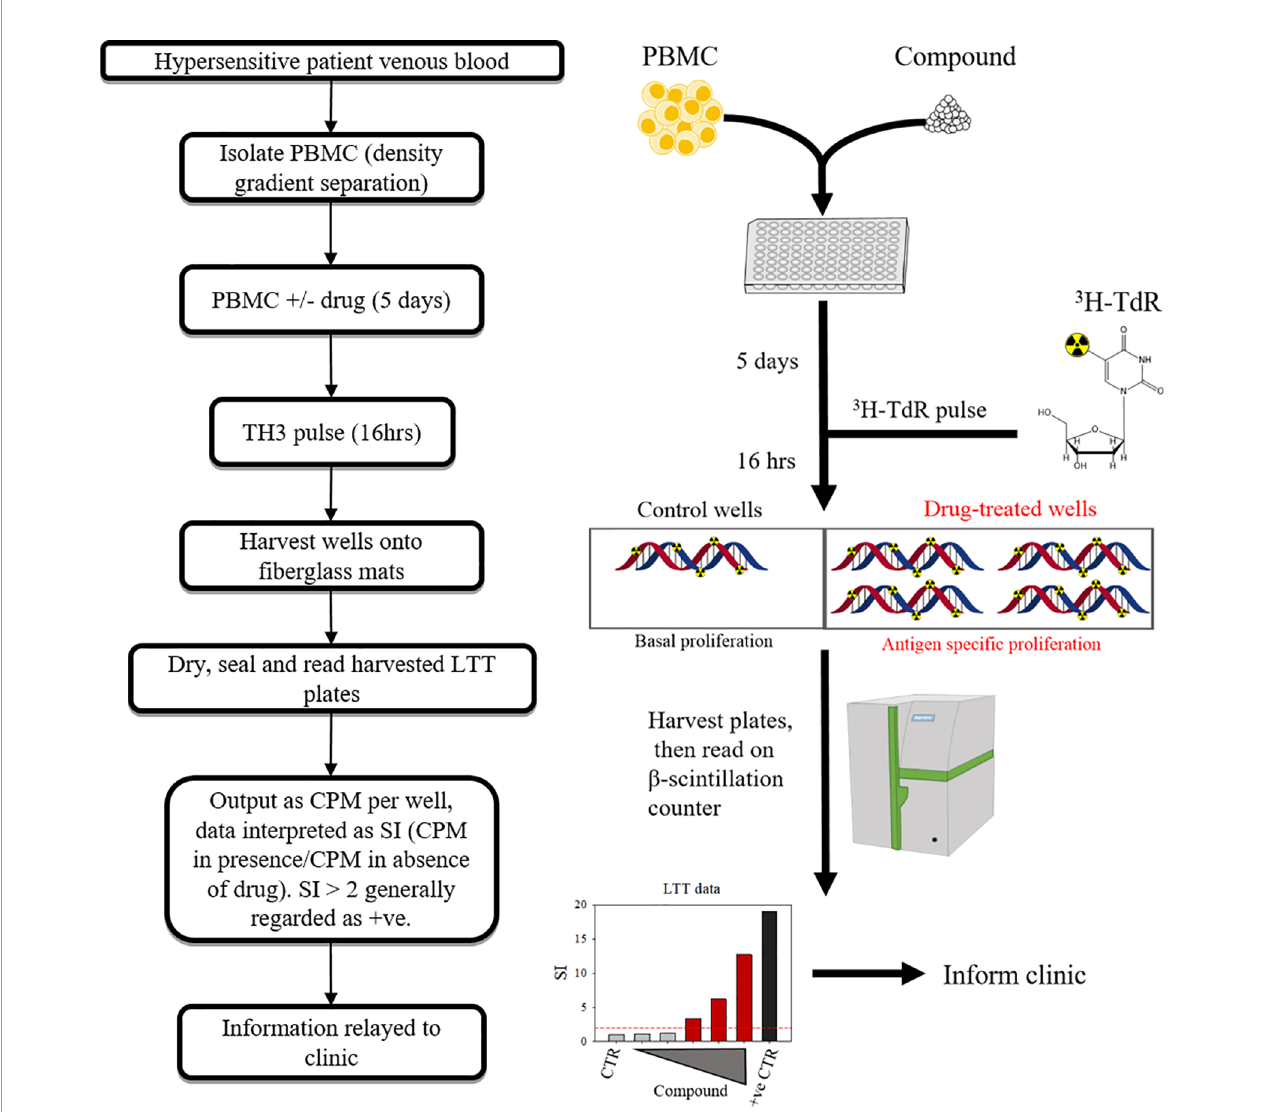
FIGURE 3 | Overview of lymphocyte transformation